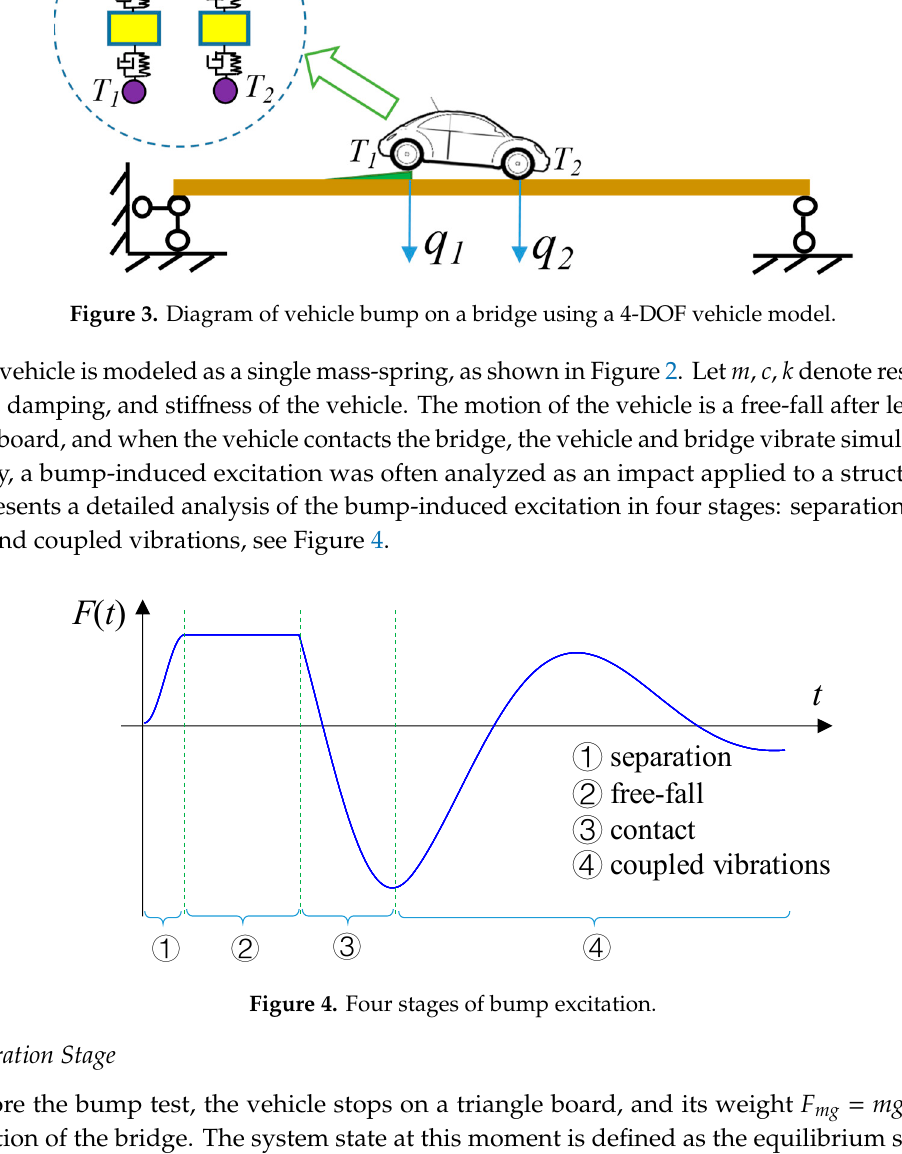
Figure 4. Four stages of bump excitation.